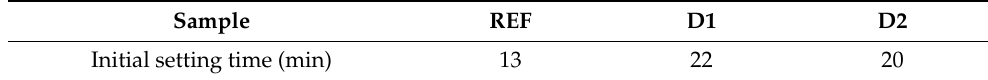
Table 5. Setting start time of the dosages